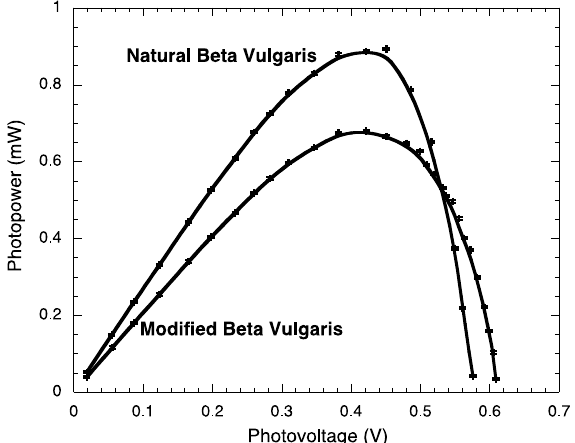
Figure 5. Power-photovoltage curves for BVE and BVE/TEOS solar